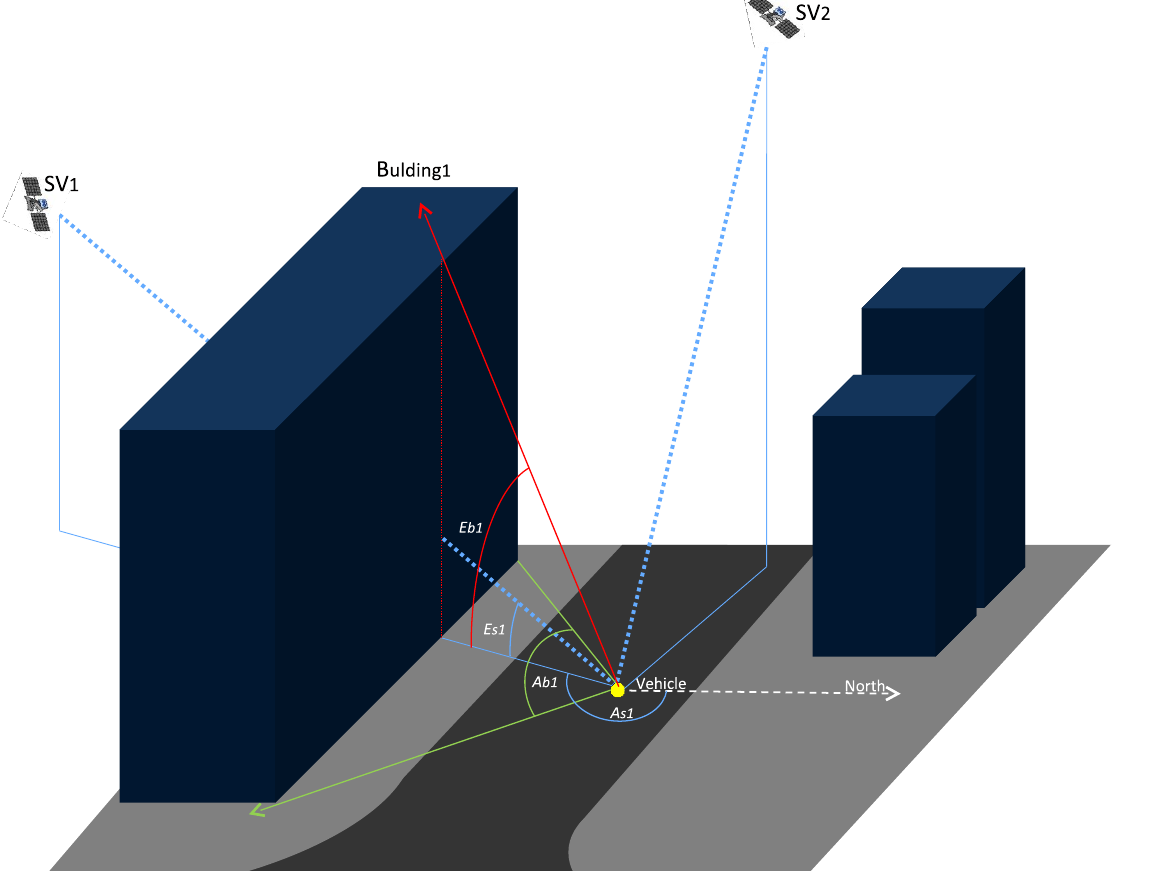
Figure 1. EEmap concept with relevant angles for the NLOS detection algorithm.